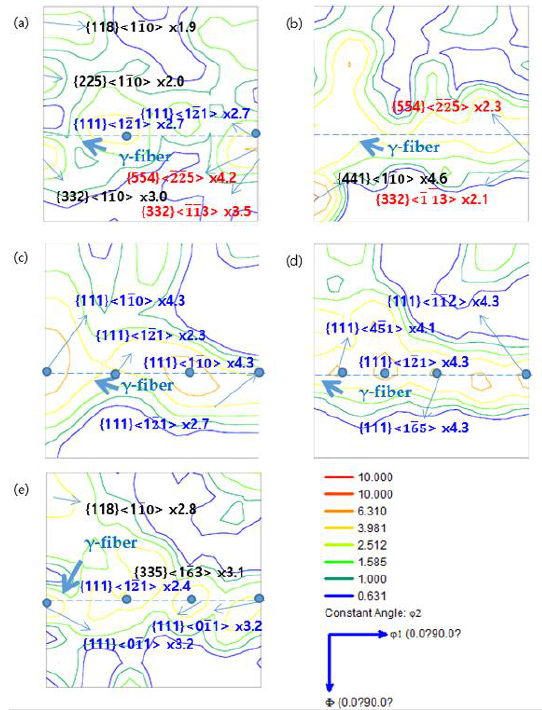
Figure 9. φ 2 = 45° section of the ODF of the Gr.92 steel specimens heat-treated under different conditions: ( a ) as-received, ( b ) 800 °C, 6 min, ( c ) 1050 °C, 6 min, and 800 °C, 6 min, ( d ) 1050 °C, 30 min, and 800 °C, 6 min, and ( e ) 1150 °C, 6 min, and 800 °C, 6 min.